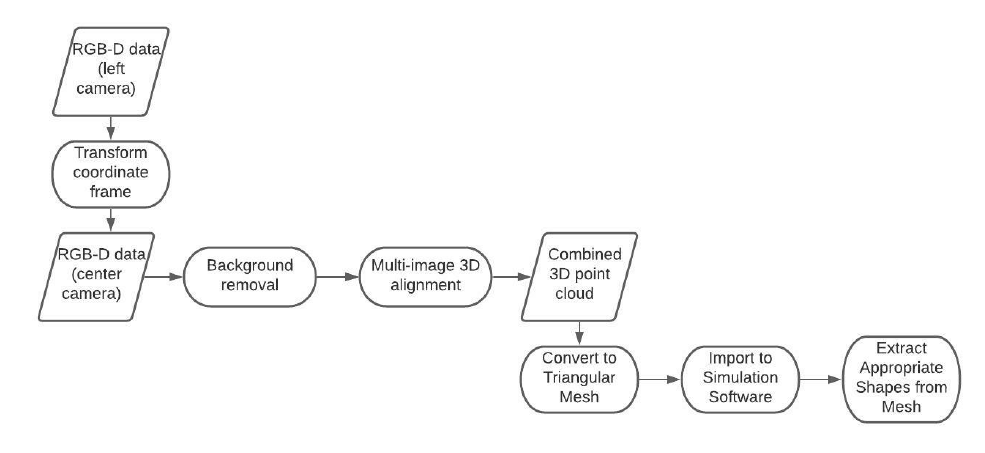
Figure 1. Environment development pipeline.